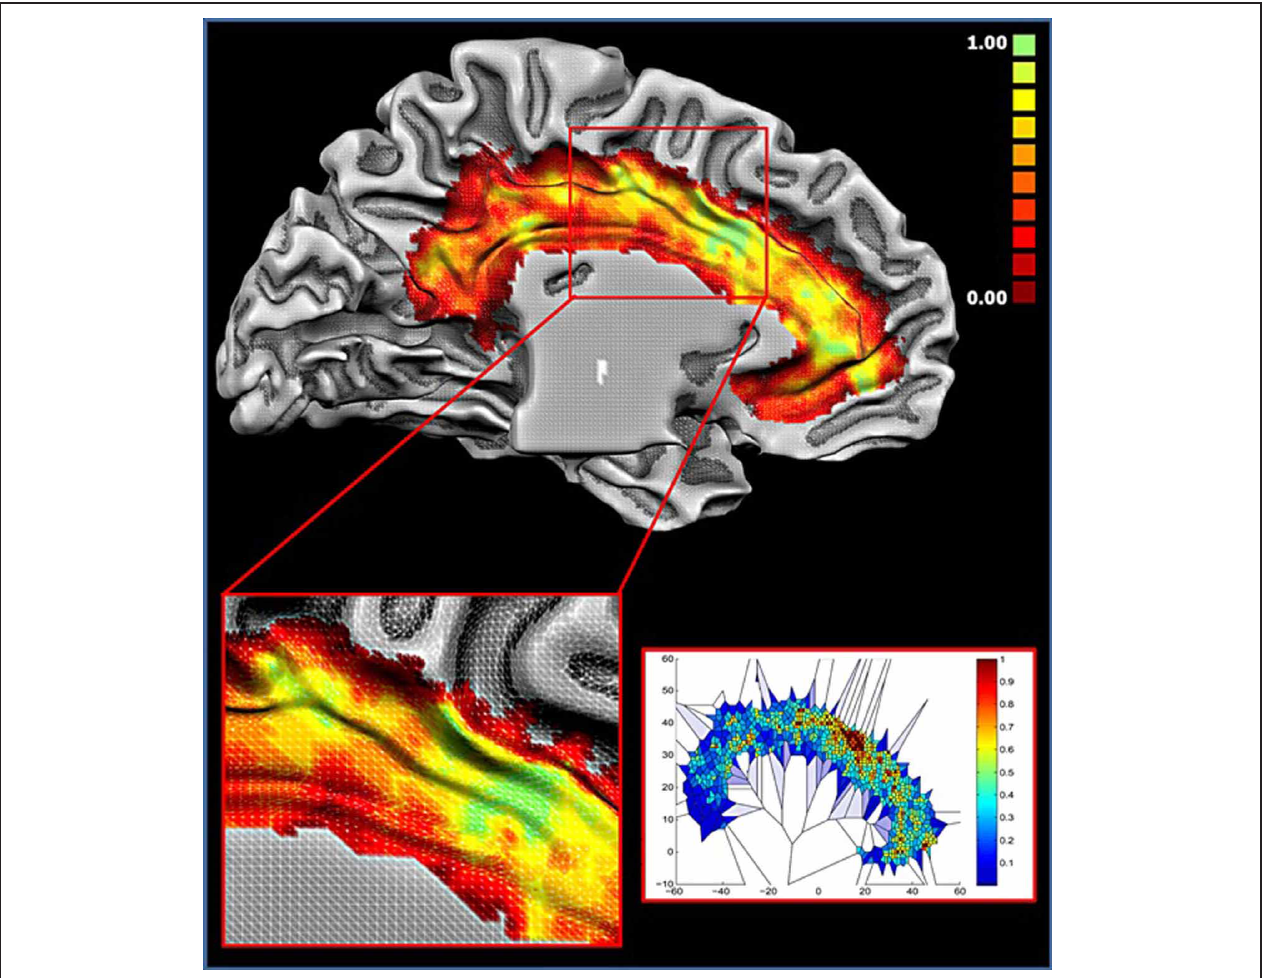
FIGURE 7 | Density of foci. Upper panel : colors from red to green represent increased foci density. Lower right panel : Voronoi tessellation of the cingulate cortex; colors from blue to red are inversely proportional to the Voronoi polygon area (i.e., Proportional to the density). All values are normalized.